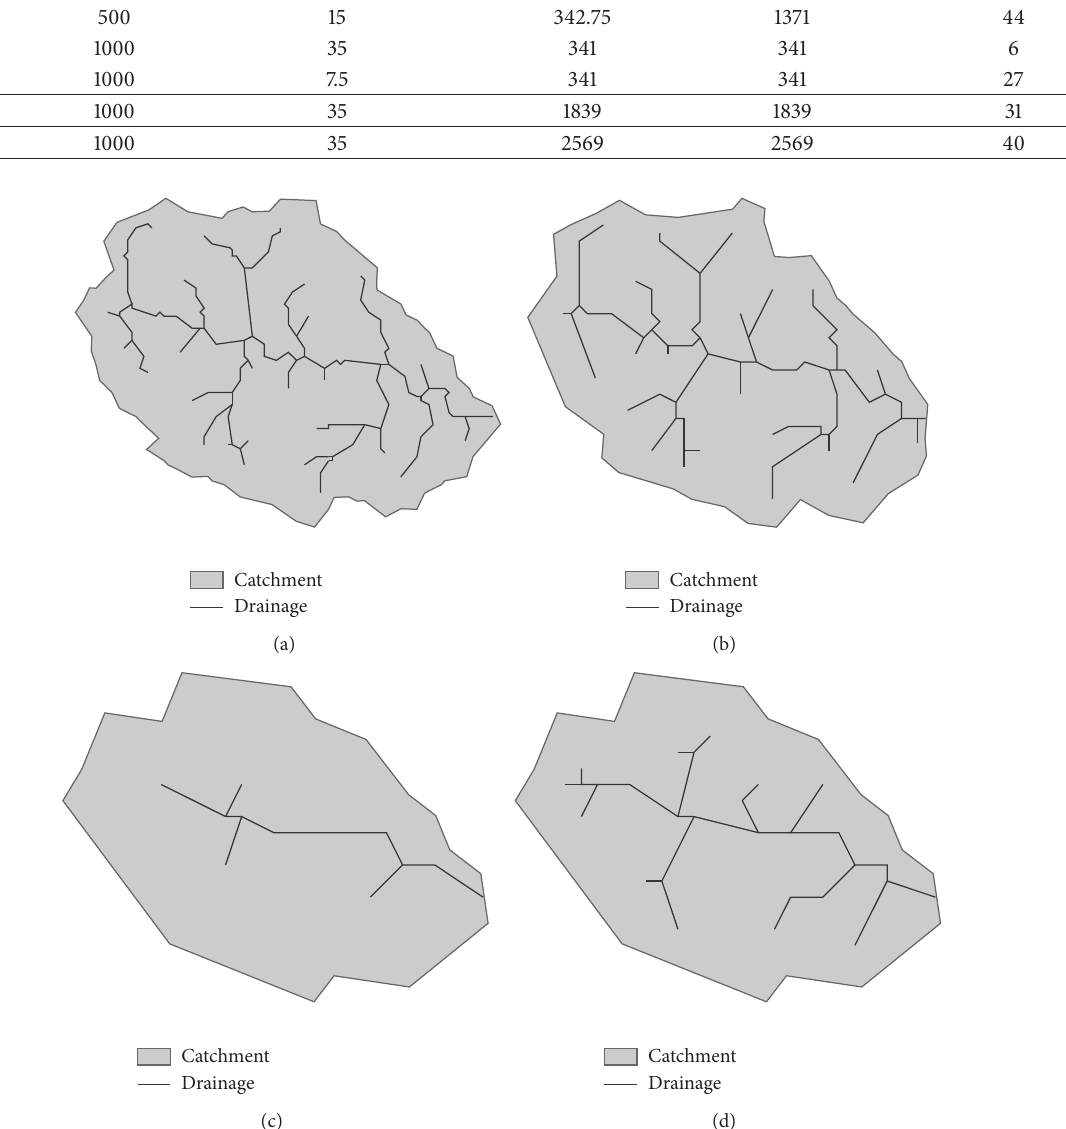
Figure 2: The catchment and drainage networks of Luanchuan, (a) resolution of 250 m, channel threshold of 60, (b) resolution of 500 m, channel threshold of 15, (c) resolution of 1000 m, channel threshold of 35, and (d) resolution of 1000m, channel threshold of